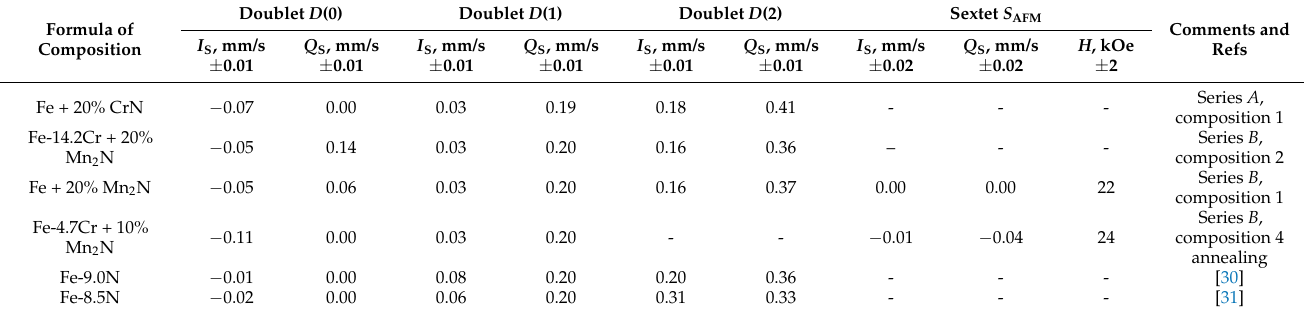
Table 3. Hyper-fine parameters of simulated spectra of the MA nitrogen-containing austenite, stainless austenite Fe–22Mn– 18Cr–0.8N steel, and nitrogen-containing γ iron. Formula of